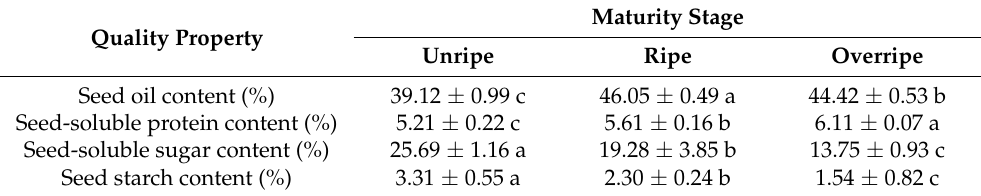
Table 3. Quality properties of Camellia oleifera with different maturity stages.